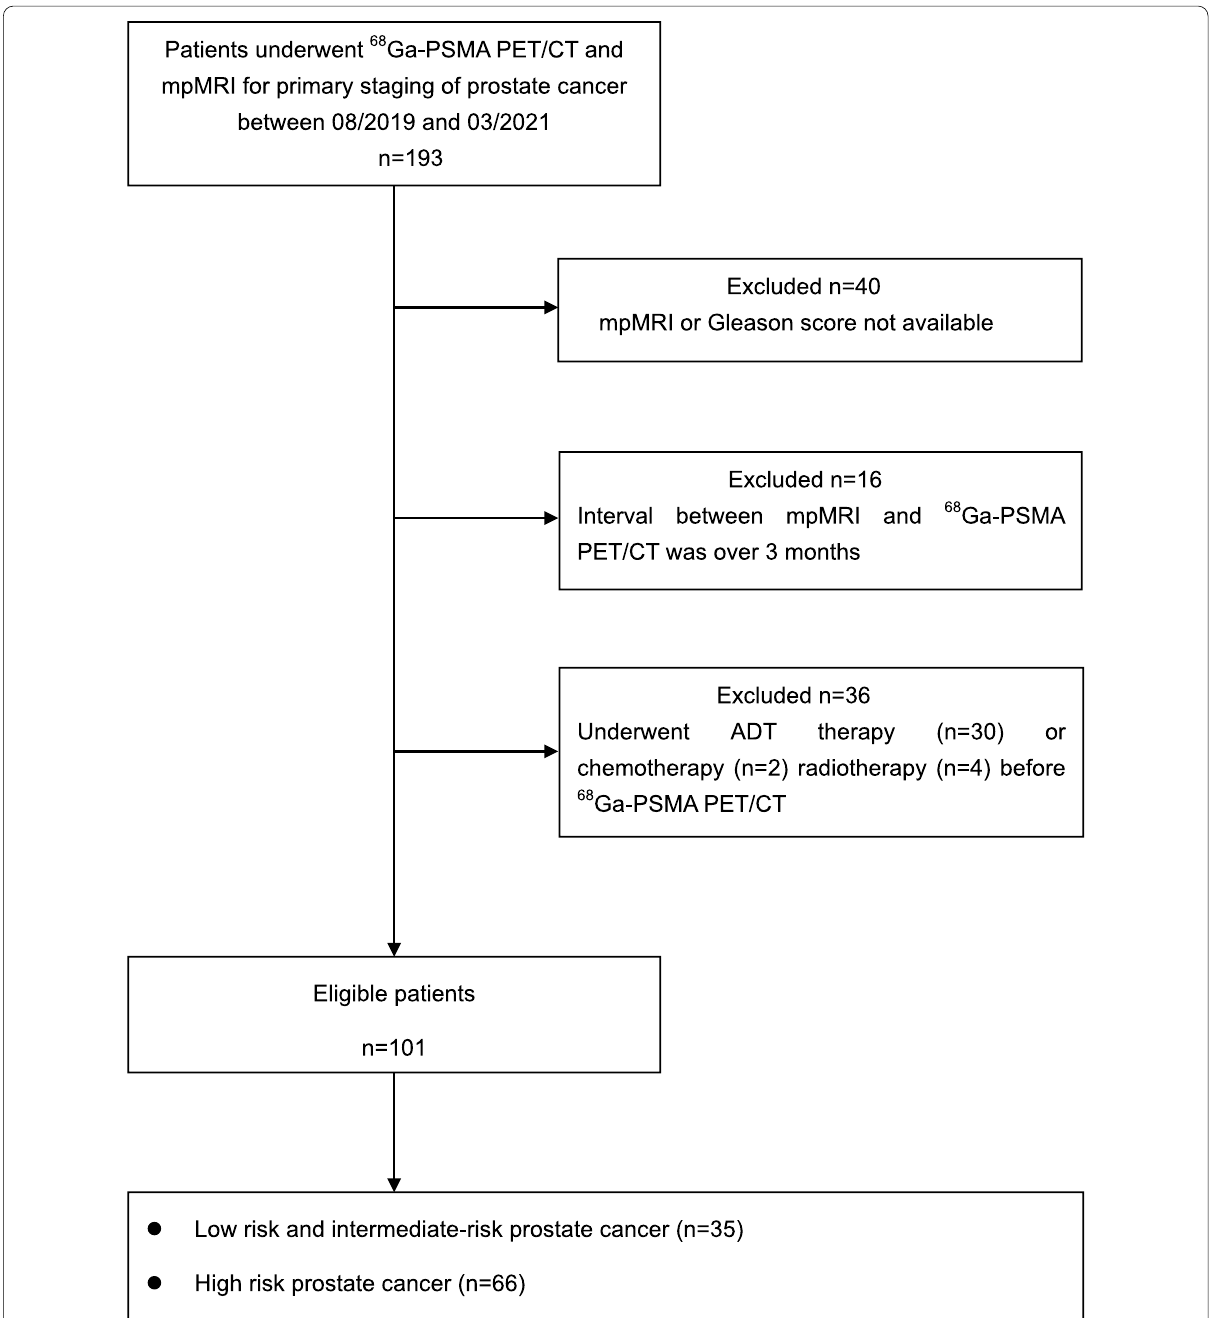
Fig. 1 Study flowchart with included and excluded patients as well as the reasons for exclusion. ADT, androgen deprivation therapy. 68 Ga-PSMA PET/CT, gallium-68 prostate-specific membrane antigen positron emission tomography/computed tomography; mpMRI, multiparametric magnetic resonance